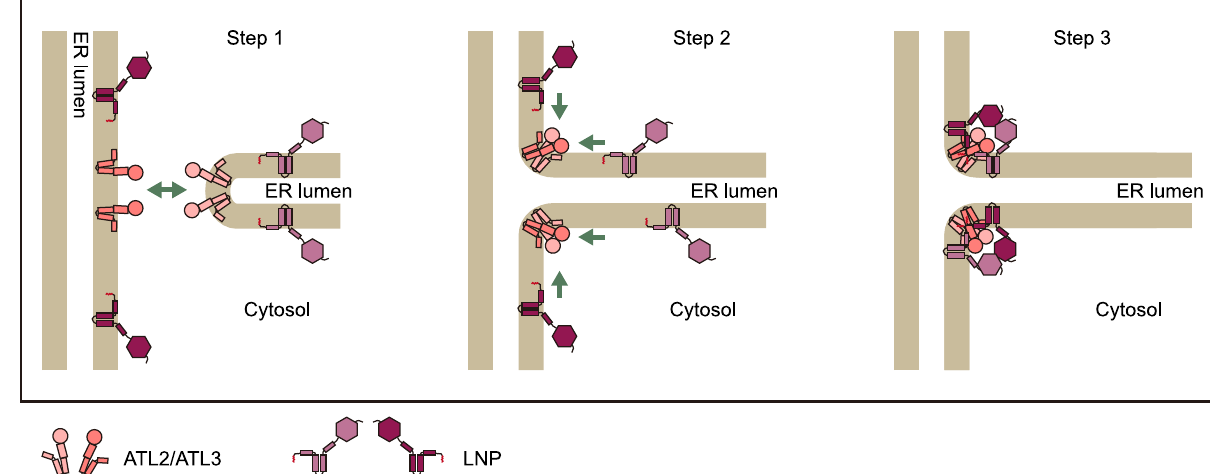
Figure 7. A model for generating three-way junctions. See “ DISCUSSION ”